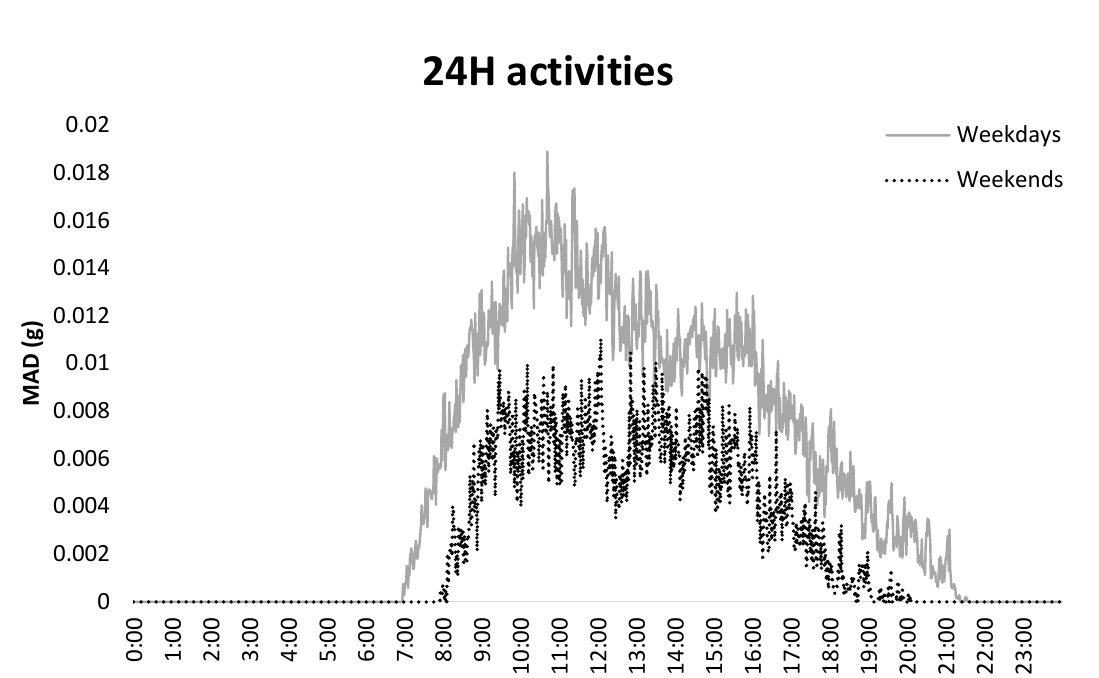
* Bold values indicate a significant difference between with vs. without unmet PA need ( p < 0.05); # Bold values indicate a significant difference between weekdays vs. weekends ( p < 0.05).